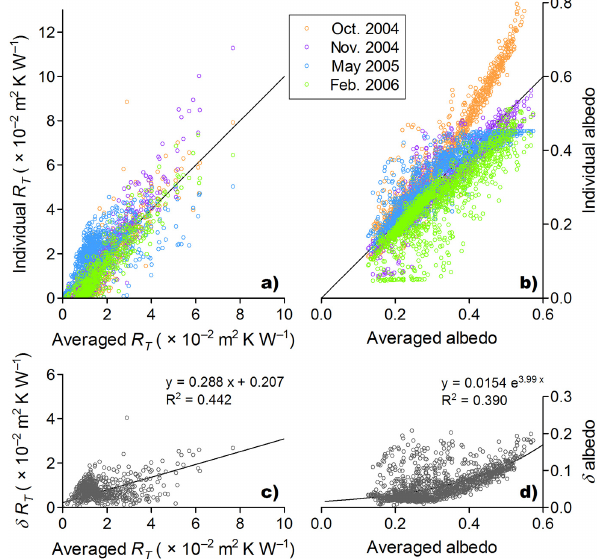
Figure 6. Scattergrams of (a) thermal resistance ( R T ) and (b) albedo of multi-temporal ASTER data against their averages, which are used to calculate ice melting under the debris-covered surface of the Trambau Glacier. Also shown are standard deviations ( σ) of (c) thermal resistance ( R T ) and (d) albedo.